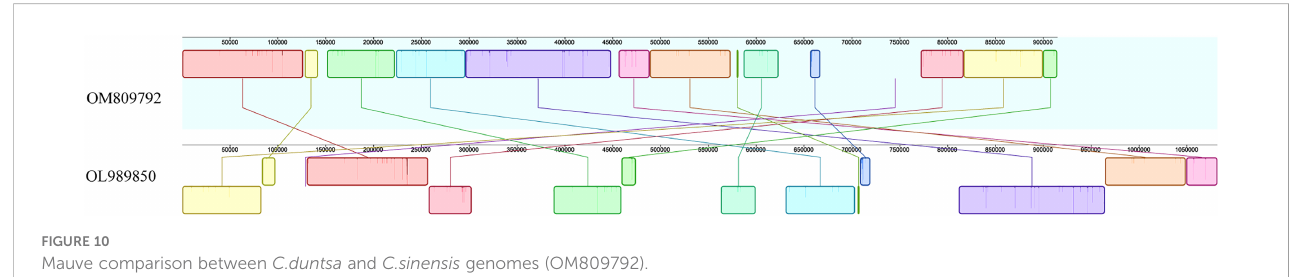
FIGURE 10 Mauve comparison between C.duntsa and C.sinensis genomes (OM809792).